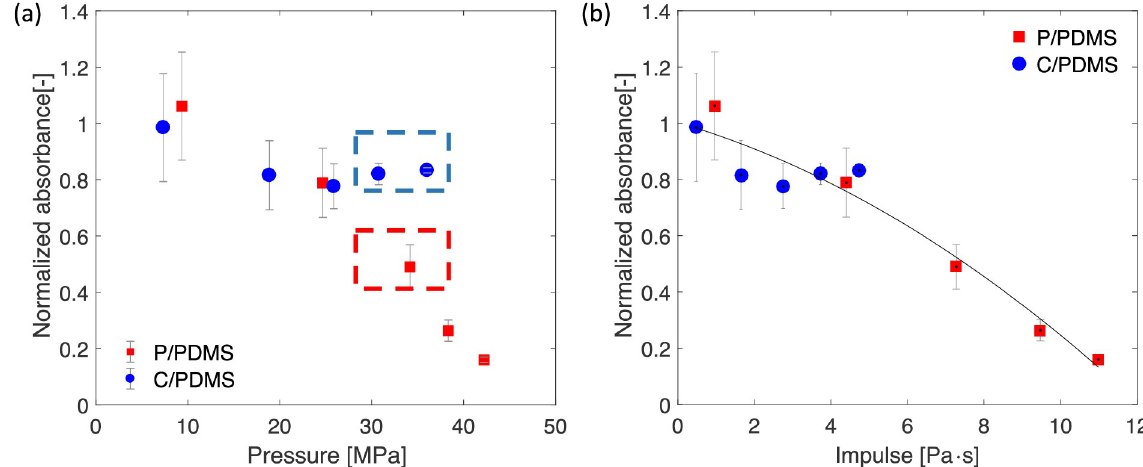
Fig 5. WST test absorbance results for both P/PDMS and C/PDMS coatings at five different laser fluence values. The absorbance values are normalized by the control group, which are untreated cells. (a) Normalized absorbance versus peak pressure. (b) Normalized absorbance versus impulse. The black line shows the fitted smoothing splines using all data points to show the overall trend. Results from three independent tests are shown. The error bars show the standard deviations from three independent tests, and each independent test include four wells for each laser